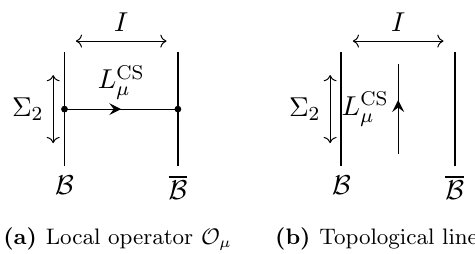
Figure 3. The G k WZW model can be obtained by considering the 2+1-d CS theory on I (cid:2) (cid:6) 2 , where I is the interval and (cid:6) 2 is the 2d spacetime of the WZW model. The boundary conditions B and B are conjugate of each other. (a): a local operator O (cid:22) in the Verma module V (cid:22) (cid:10) V (cid:22) can be realized as the Wilson line L CS in the representation (cid:22) bridging the two boundaries. (b): a (cid:22)